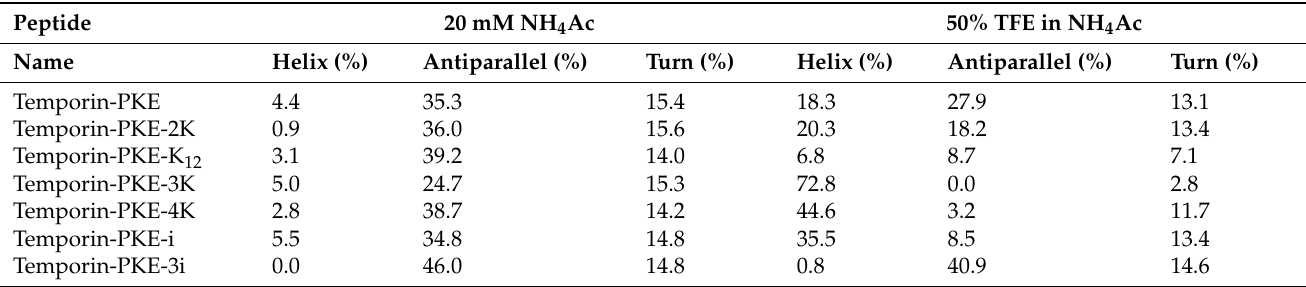
Table 3. Secondary structure analysis of temporin-PKE and its